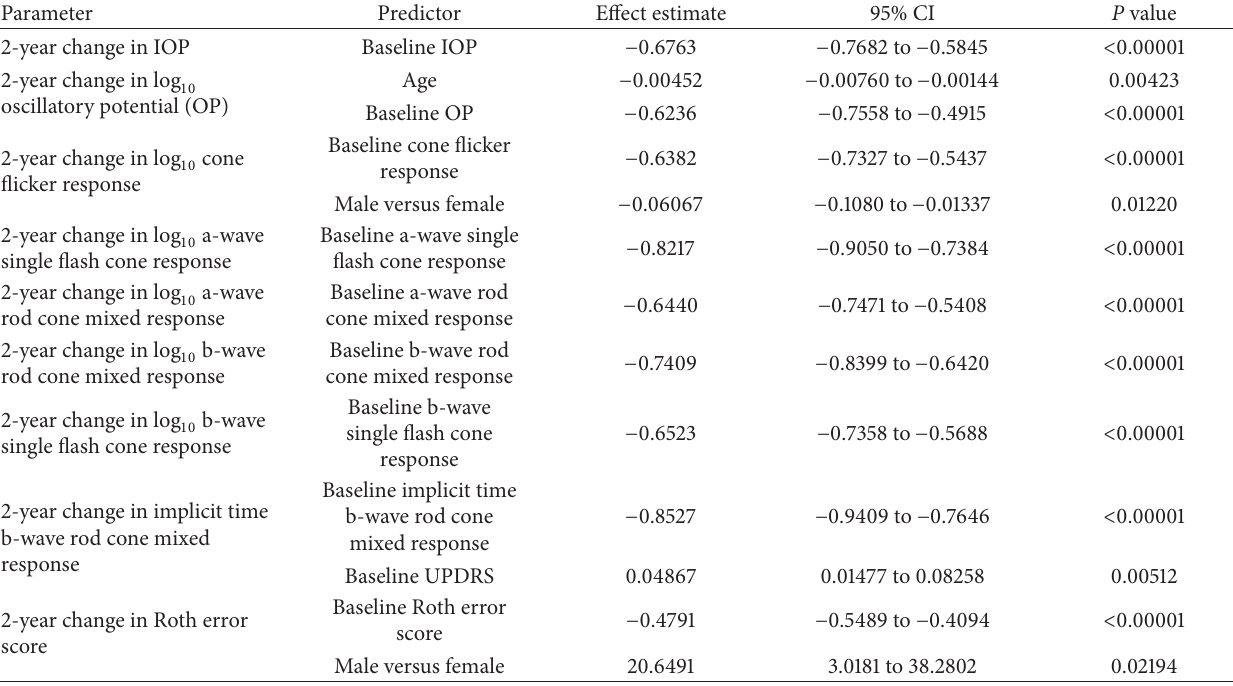
Table 7: Statistically significant ( 𝑃 < 0.05 ) multivariate predictors of 2-year change in ophthalmologic parameters and ERG amplitudes (log 10 [ERG amplitude] difference from baseline to 2 years). Longitudinal models were developed for all eyes as described in Section